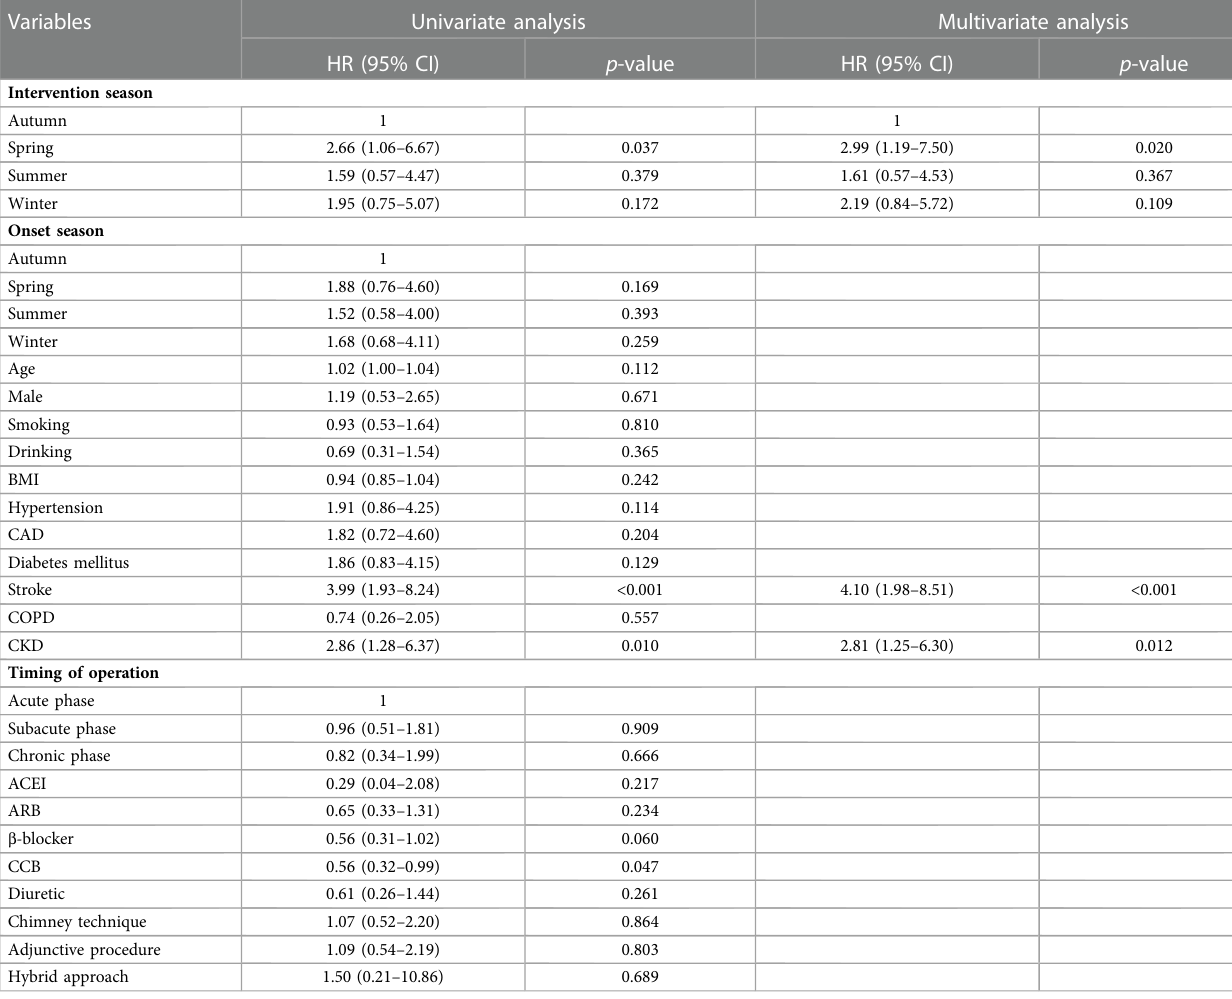
TABLE 5 Univariate and multivariate cox regression analysis of 1-year all-cause mortality of type B aortic dissection patients.